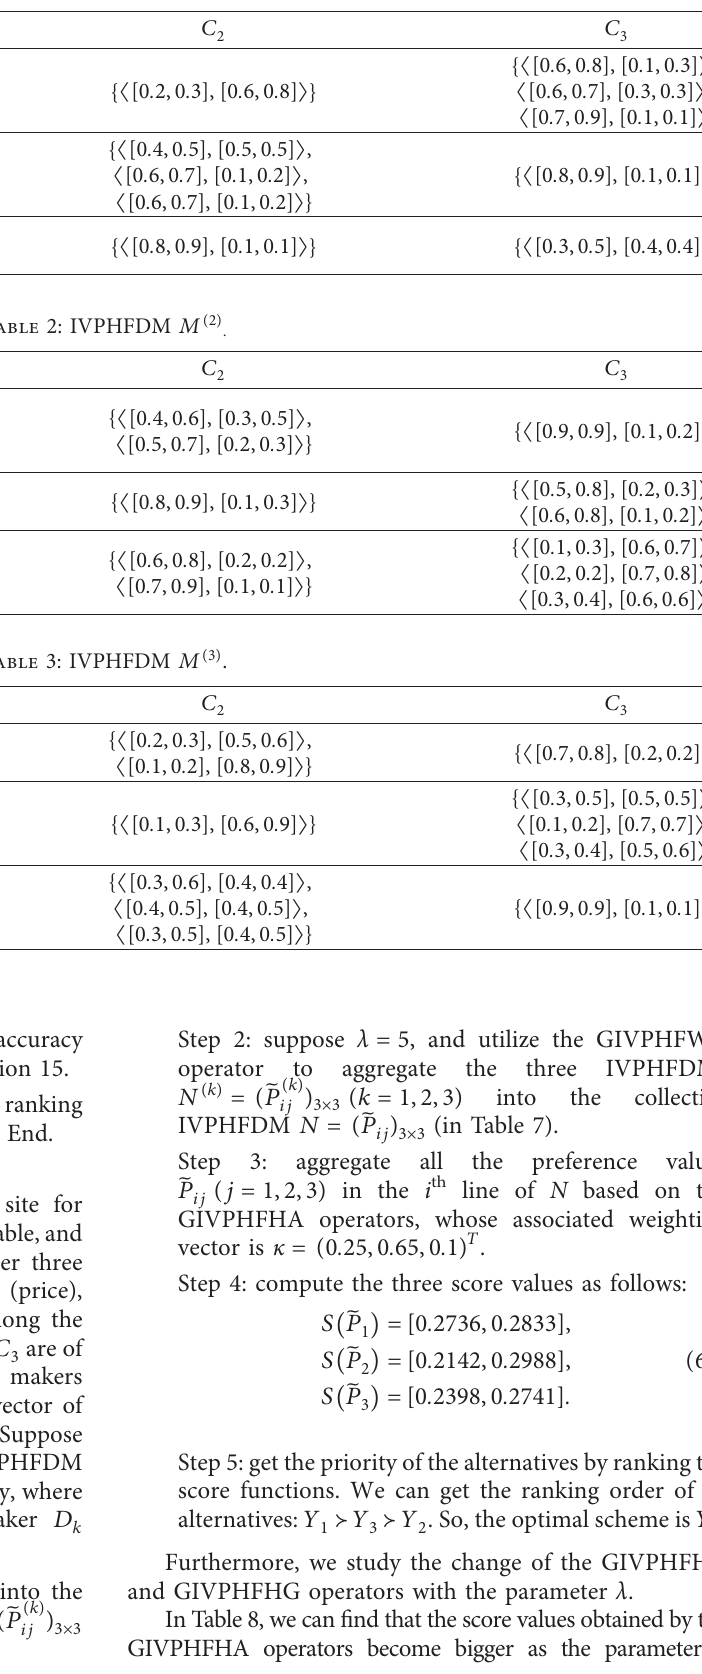
Table 1: IVPHFDM M ( 1 ) .